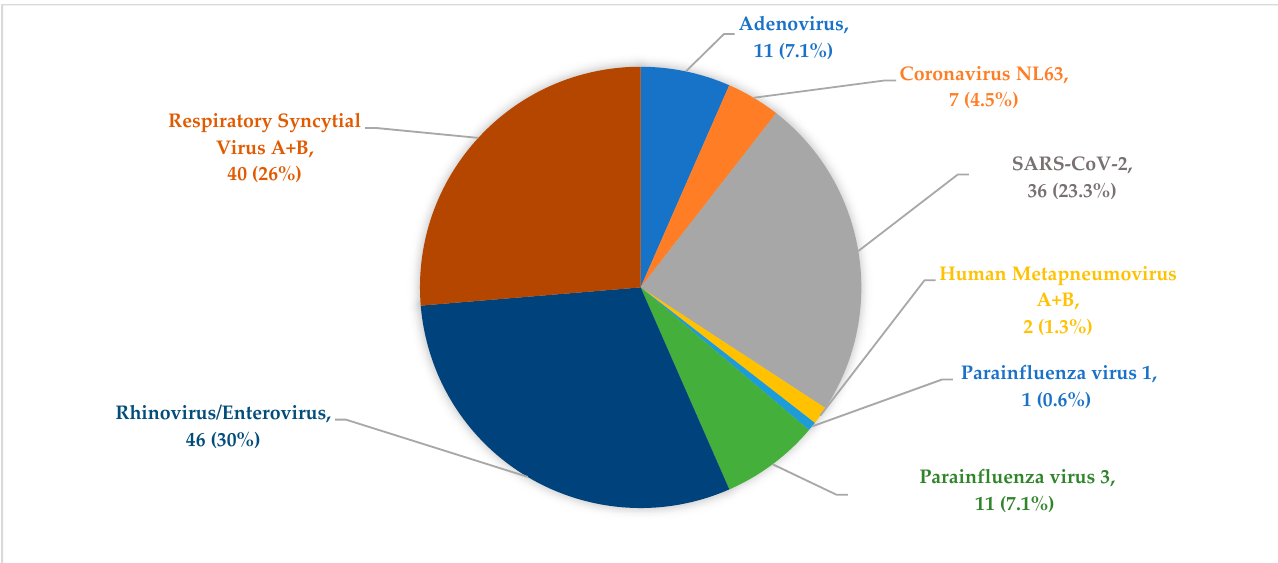
Figure 1. Profile of pathogens detected in all 74 positive samples across the three periods reviewed (during and between the second and third wave of the COVID-19 pandemic) depicting the percentage of detection frequency of each virus. SARS-CoV-2 = severe acute respiratory syndrome coronavirus 2. Table 2. Pathogens detected in single and co-infections and detected Ct values.